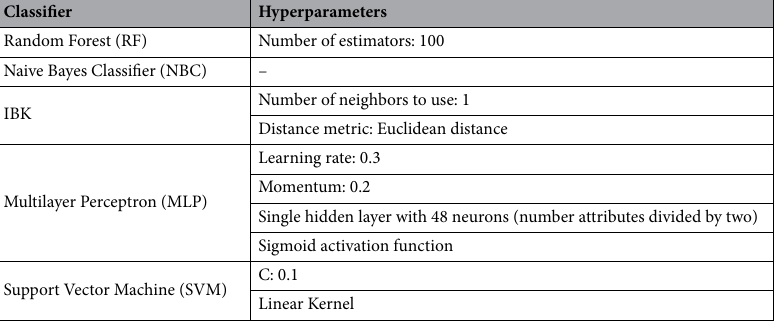
Table 1. Classifiers parameters: SVMs with linear kernel; MLPs with 48 neurons in the hidden layer; random forests with 100 trees; and standard IBK and Bayesian networks.